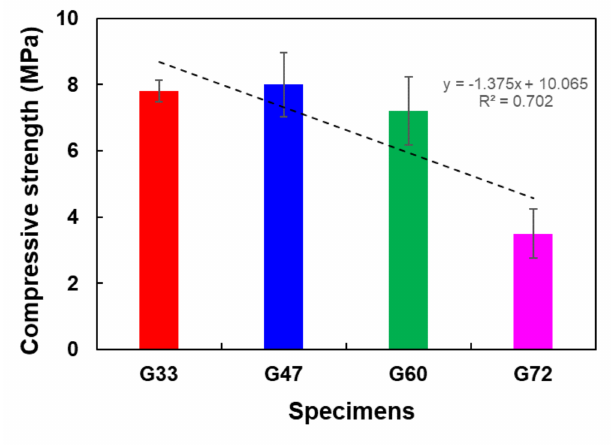
Figure 7. Compressive strength results of PPM